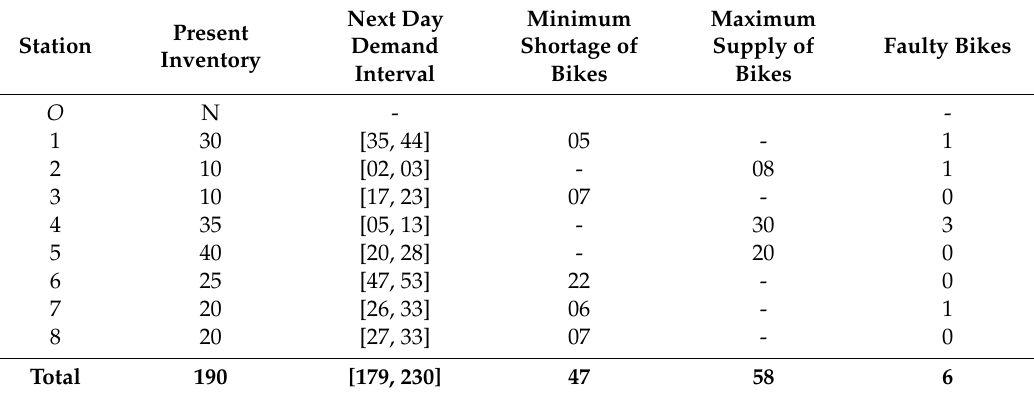
Figure 1. The location of a depot and stations in a bike-sharing scheme. Table 3. The number of present usable and faulty bikes, and the next day demand at each